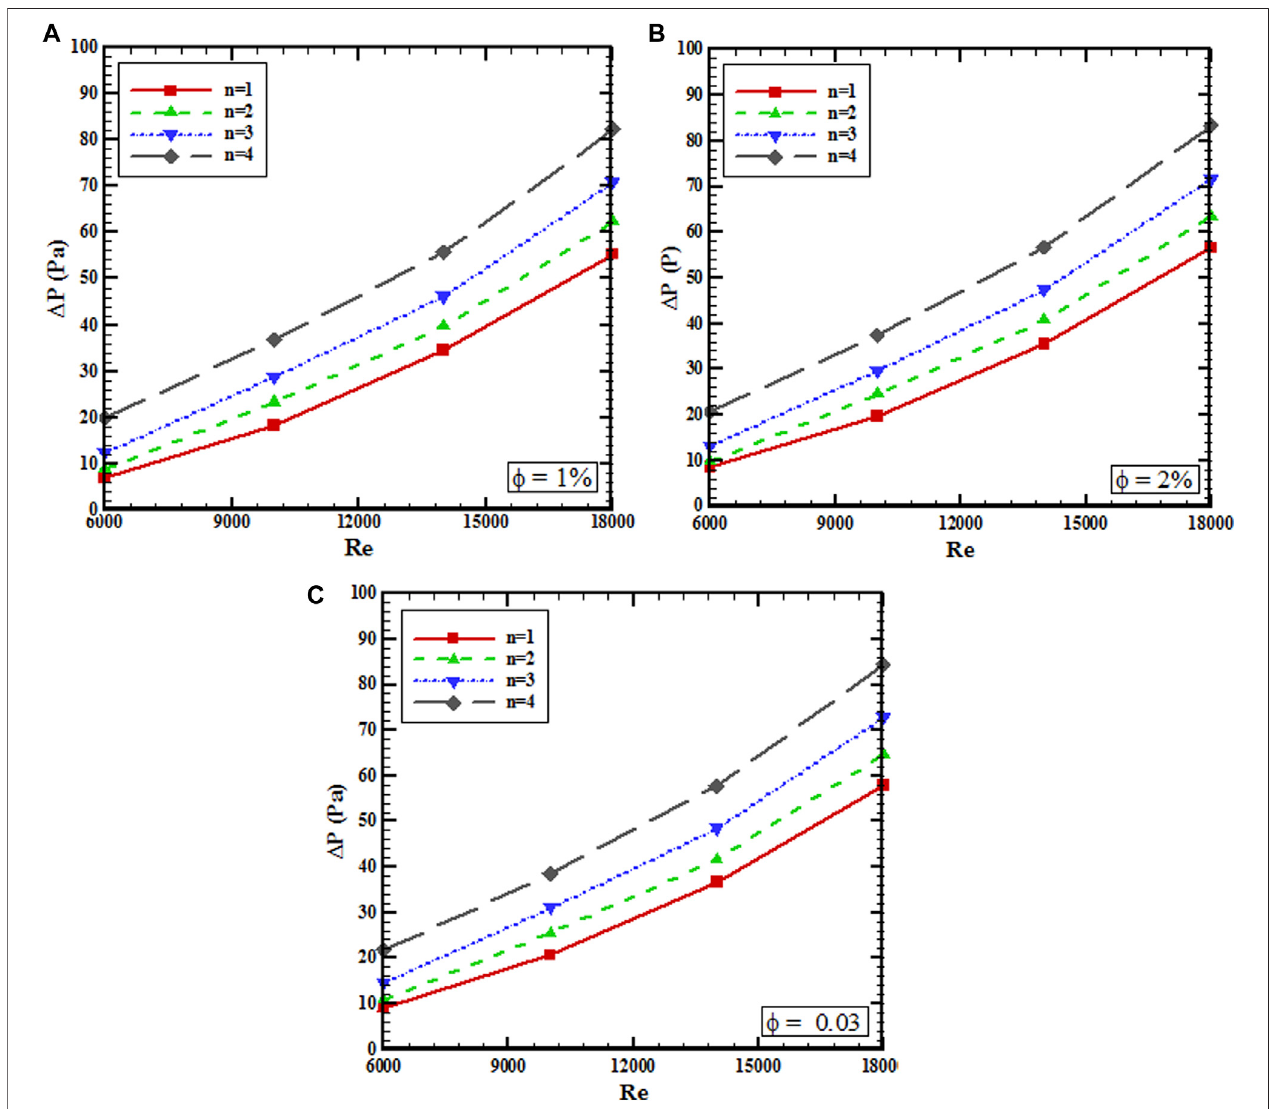
FIGURE 10 | The variations of pressure drop at (A) φ (cid:1) 1%, (B) φ (cid:1) 2%, and (C) φ (cid:1) 3%.